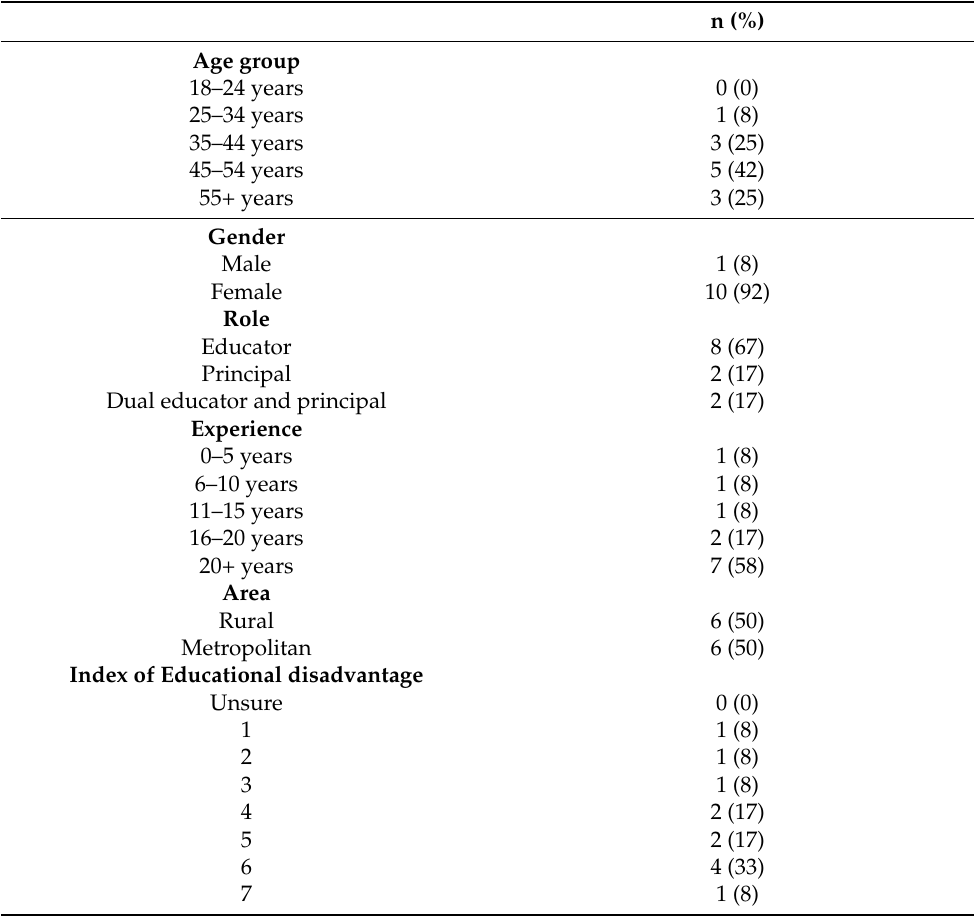
Table 1. The demographic characteristics of participants (n = 12) and their